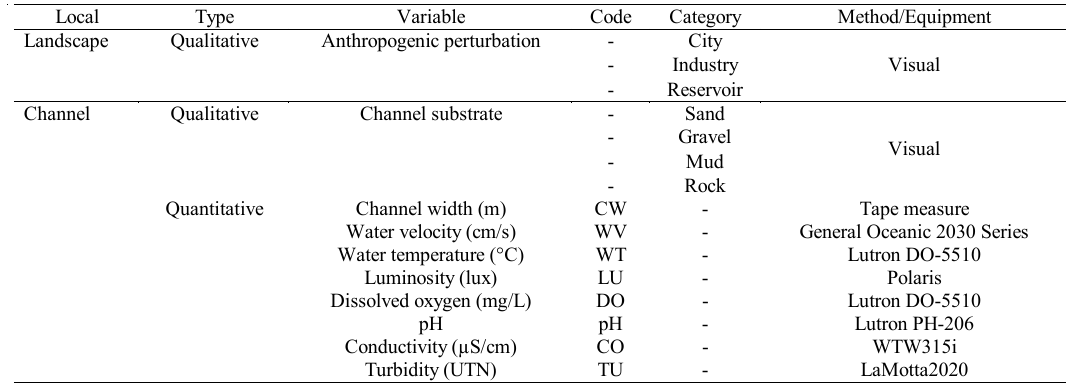
Table 2. Qualitative and quantitative variables measured in the Ouvidor River and its